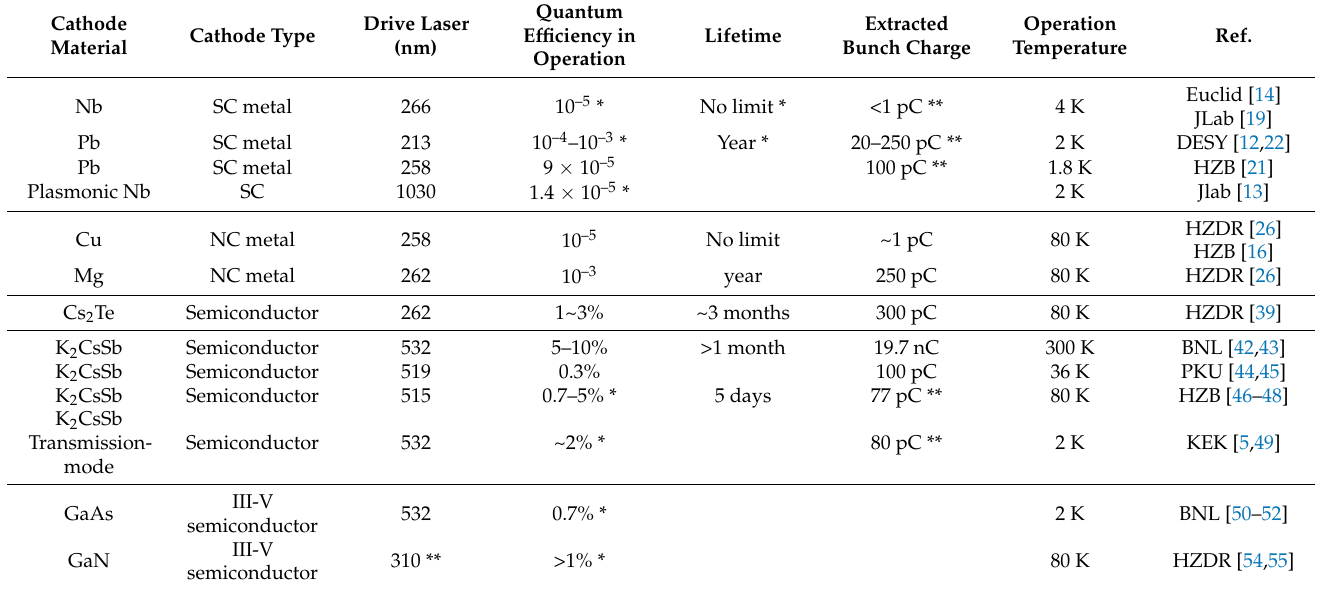
Table 2. Operation properties of photocathodes for SRF